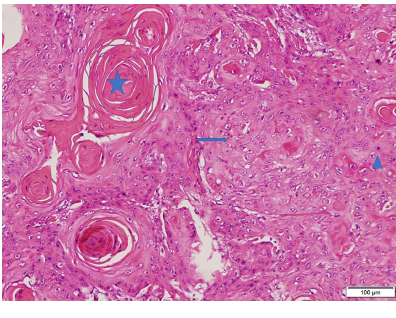
Figure 2. The histopathological evaluation of the excision materal was consistent with cSCC diagnosis; HE X100 star: Easily recognizable squamous epithelium, abundant keratinization arrow: minimal pleomorphism arrow head: mitotic figures. cSCC, cutaneous squamous cell